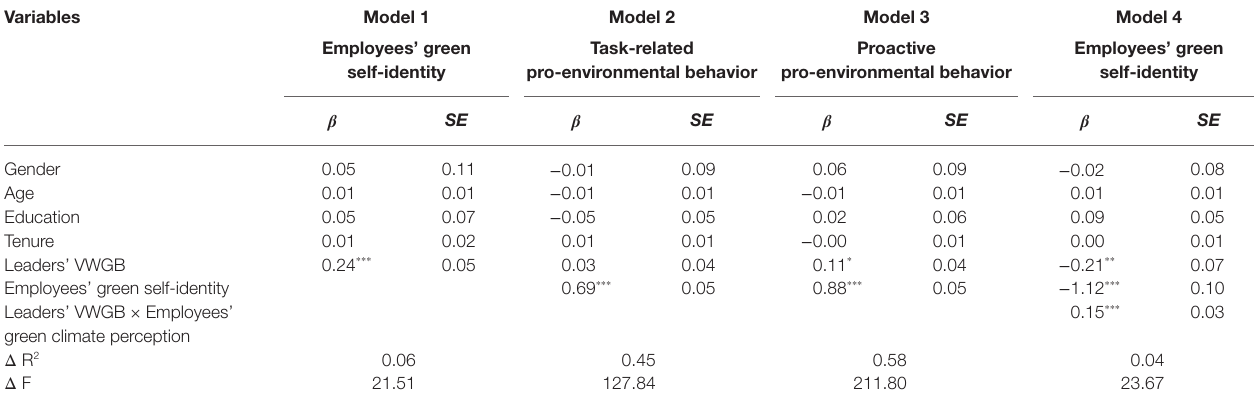
TABLE 3 | Results of simple regression.